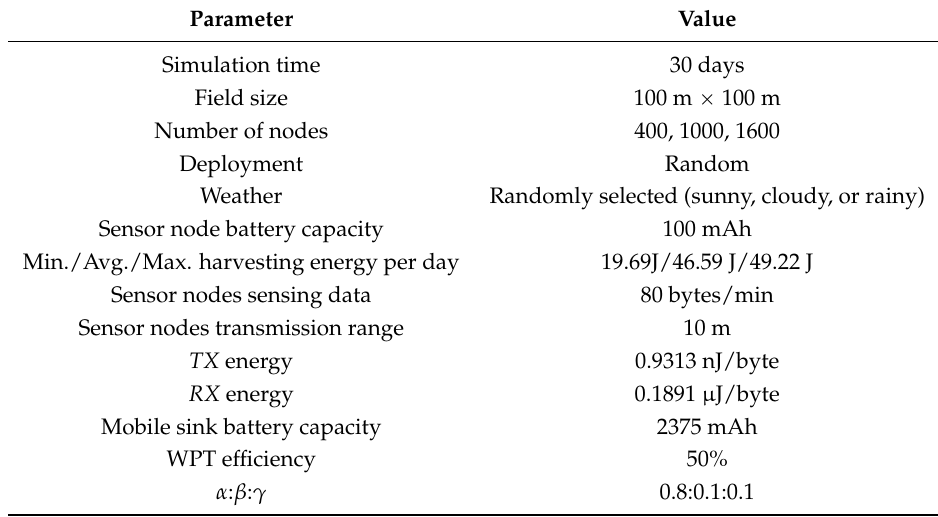
Table 4. Simulation